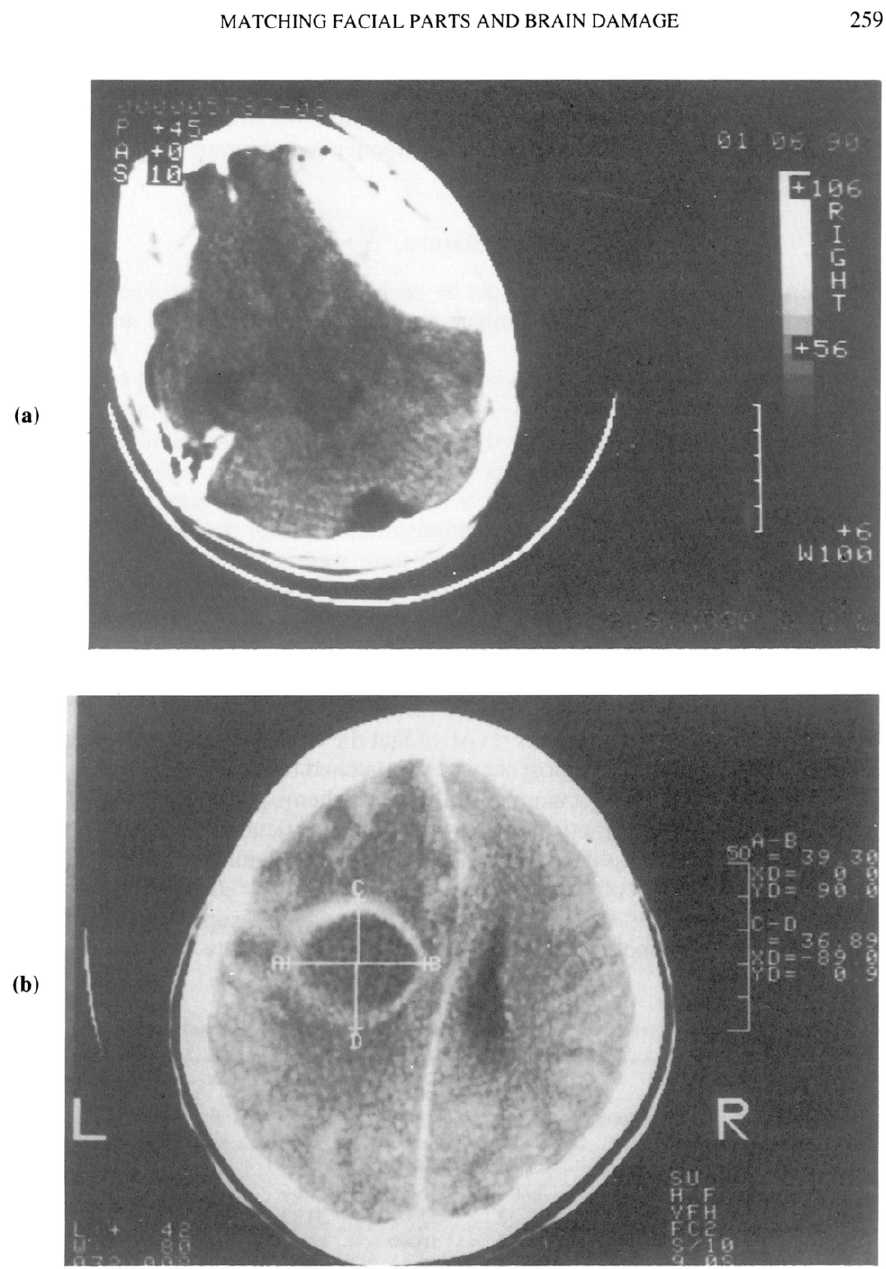
FIG. 2. Aciuallesion site (CT) in representative cases (refer Table I for subject number shown in parenthesis). (a) Right franta-temporal damage (5); (b) left parietal damage